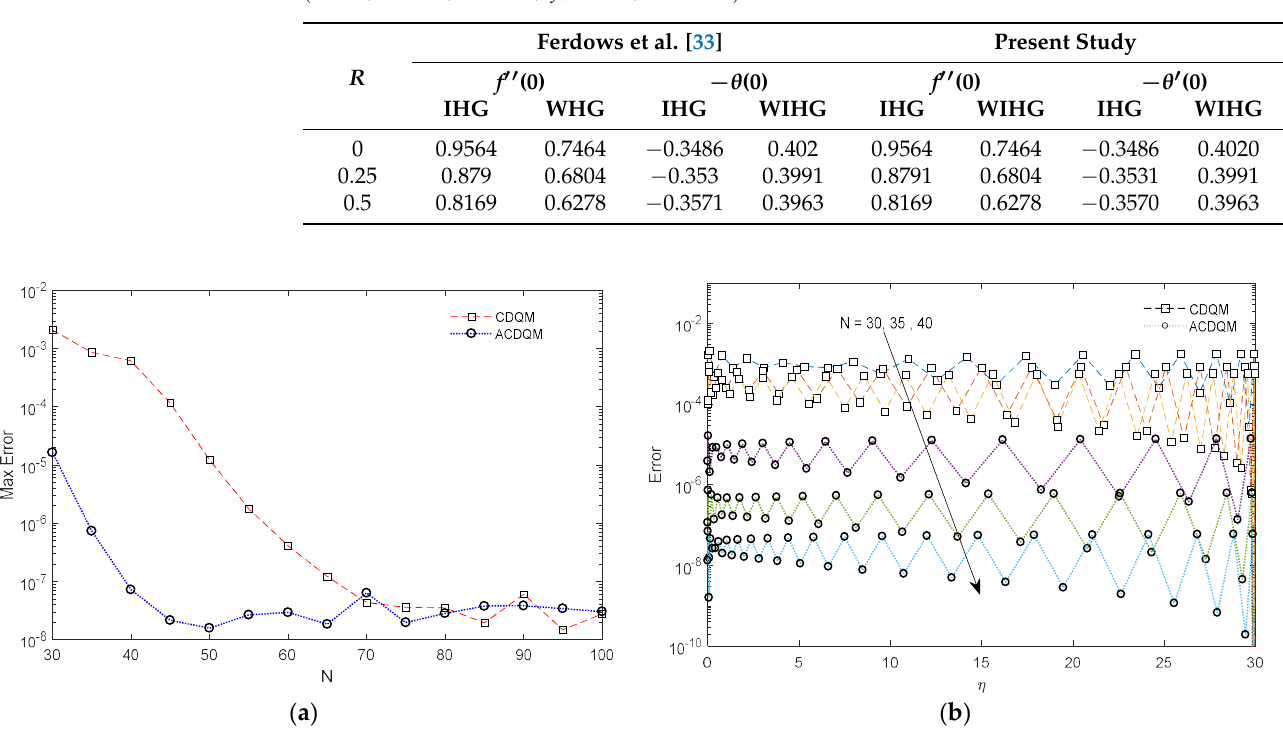
Figure 2. Maximum absolute error versus the number of grid points ( a ) and the absolute error distribution overall in the problem domain ( b ) at N = 30, 35, 40 for the CDQM and ACQDM at R = 0.5, M = 1, λ = 0.5, c = 1, B = 0.2, φ 1 = φ 2 = 0.1, Da = 1; Rd = 1, n =